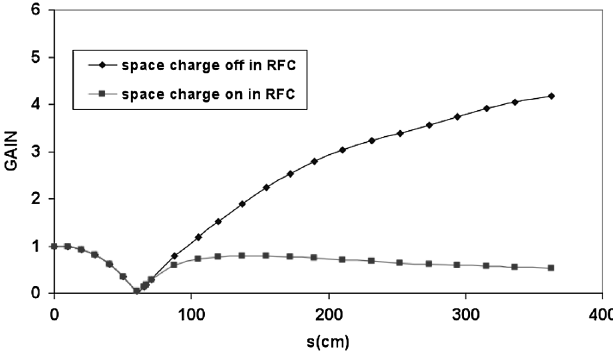
¼ (cid:1) 82 deg ( C (cid:7) 2 ) with 0